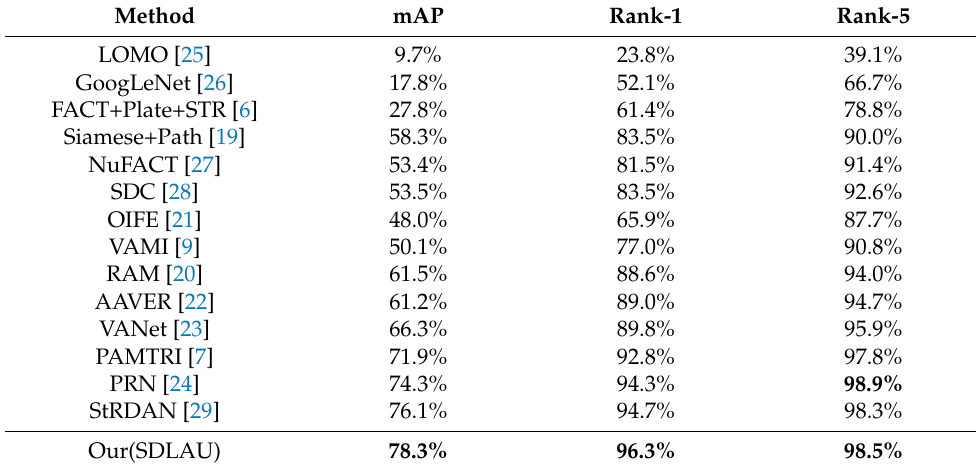
Table 2. Experimental comparison results of VeRi-776 dataset.